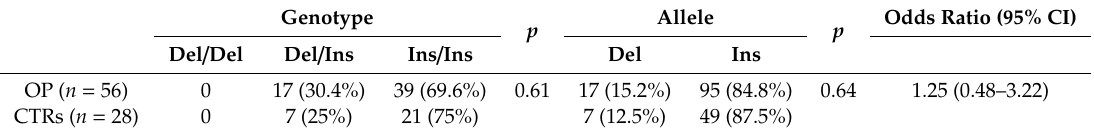
Table 2. Distribution of the genotypes and allelic frequencies of rs145204276 in OP patients and CTRs. Genotype